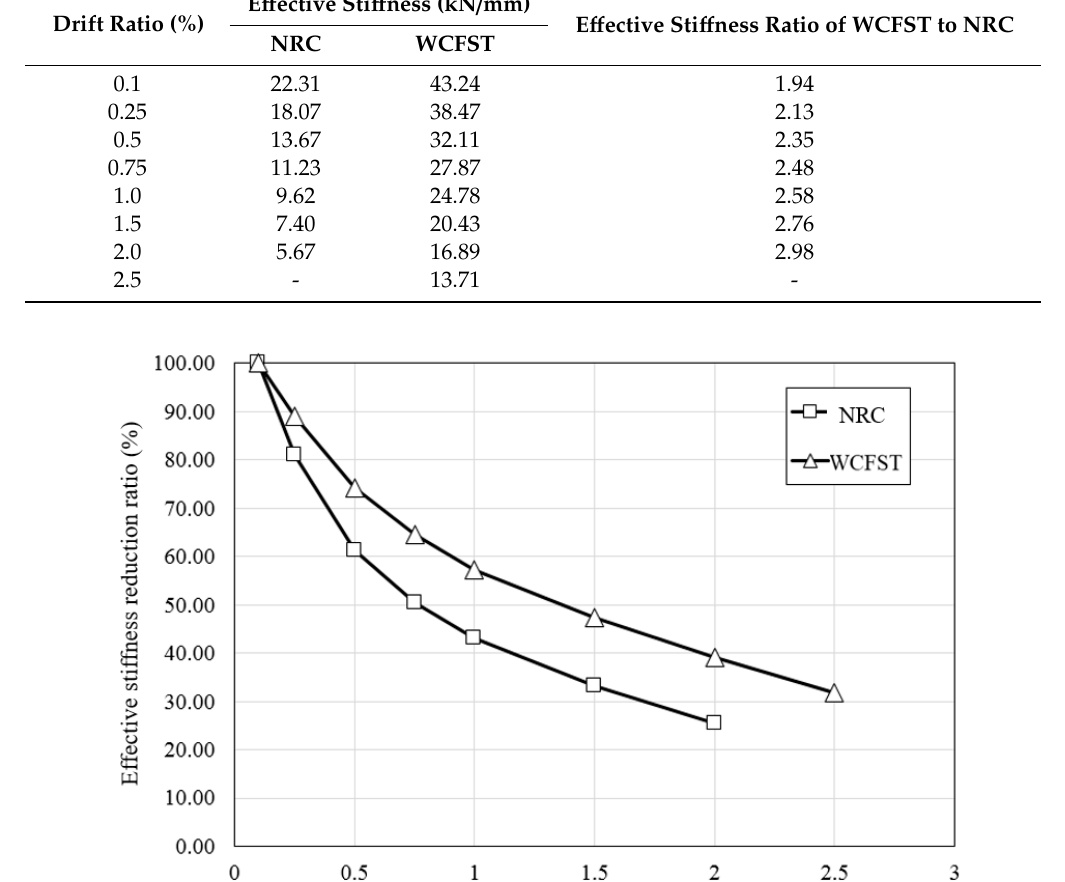
Table 5. Comparison of cumulative energy dissipation according to the drift ratio.